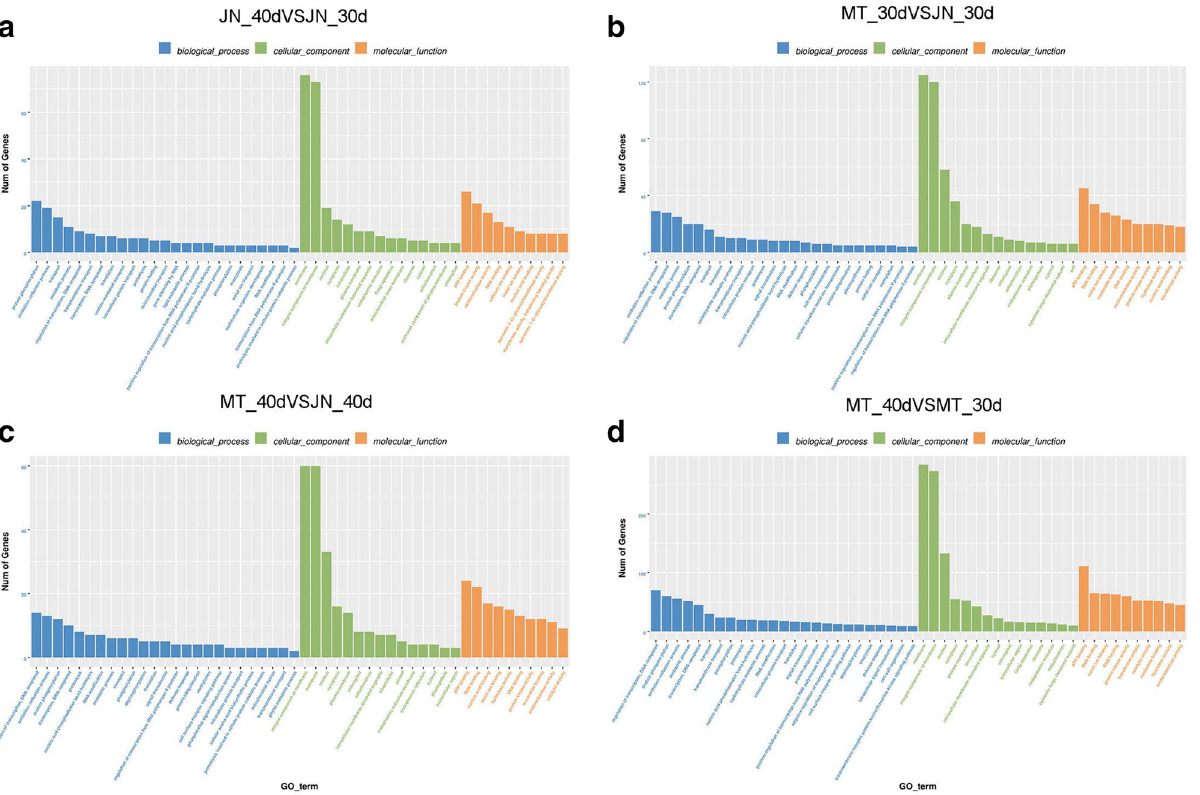
Figure 8. Gene ontology analysis of target protein-coding genes of differentially expressed lncRNAs in soybean. ( a ) JN_40 versus JN_30, ( b ) MT_30 versus JN_30, ( c ) MT_40 versus JN_40, ( b ). MT_40 versus MT_30. MT_40, MT72 at 40 d after flowering, MT_30, MT72 at 30 d, JN_40, JN18 at 40 d, JN_30, JN18 at 30